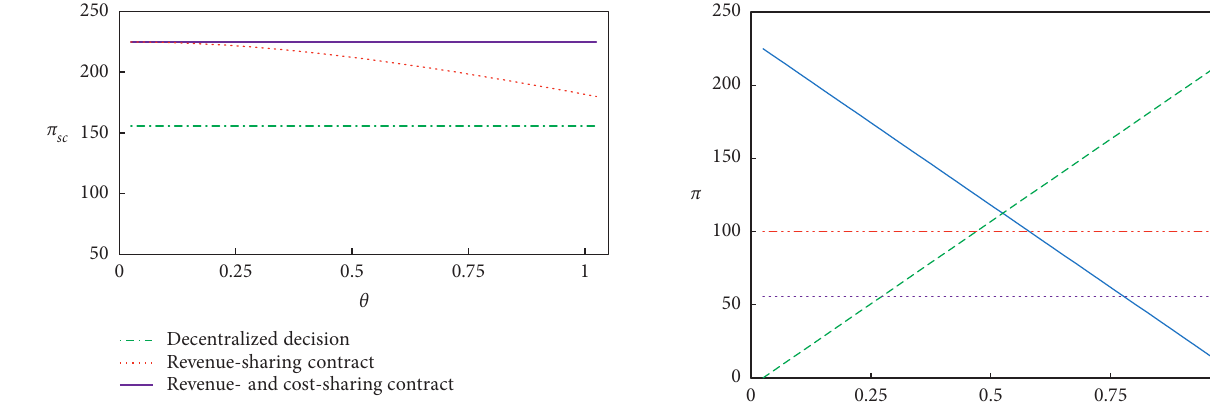
Figure 8: Impact of revenue-sharing coefficient on the supply chain’s profits.